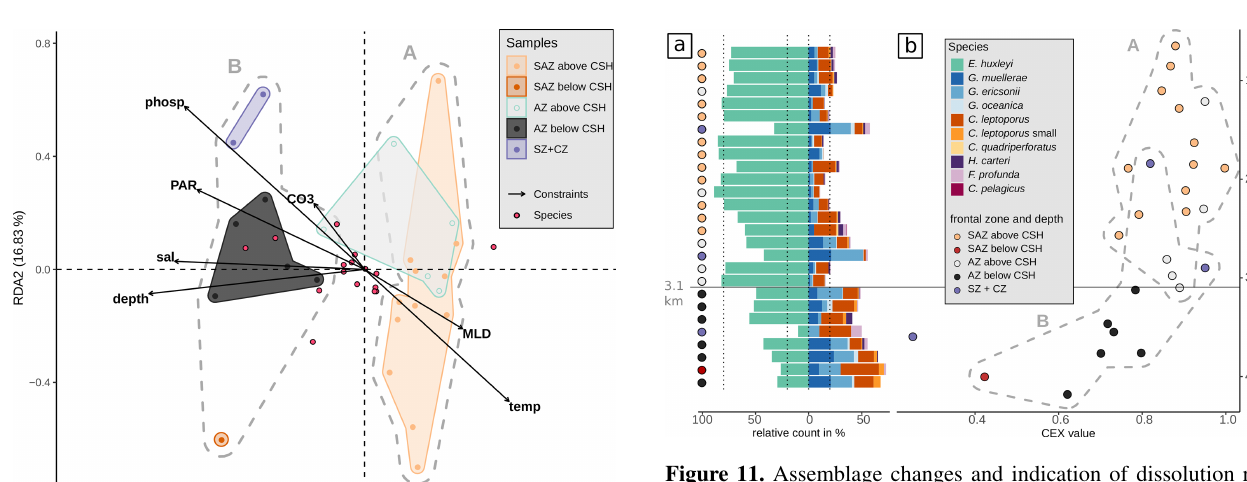
Figure 11. Assemblage changes and indication of dissolution re- lated to water depth. (a) Relative proportions of the delicate E. hux- leyi versus the more dissolution-resistant Gephyrocapsa and Cal- cidiscus taxa as well as H. carteri , F. profunda and C. pelagicus . Figure 10. Redundancy analysis based on Hellinger distances (tb- Below 3.1km and in the SZ + CZ, species of the genera Gephyro- RDA) with an explained variation in species composition by the in- capsa and Calcidiscus dominate the surface sediment assemblages. put environmental variables (adjusted R 2 ) of 38.3%. Biplot of the (b) Calcidiscus leptoporus – Emiliania huxleyi Dissolution Index first two RDA axes explaining 84.3% of the (constrained) variance (CEX, Dittert et al., 1999; see Eq. 2) against water depth. Dashed between the environmental parameters (black arrows), the species outlines indicate the clusters A and B as suggested by cluster analy- (blue dots) and the samples (coloured dots). Grey dashed hulls out- sis, distinguishing clearly the shallower samples above 3.1km from line the clusters (A and B) from the hierarchical cluster analysis; deeper samples below 3.1km (and from SZ + CZ), with the highest coloured hulls outline the samples from different frontal zones and CEX values in cluster B. The sample outside cluster B (PS97/077- above or below a depth of 3.1km. Considered explaining variables 1) was not included in the hierarchical cluster analysis. Note that the are sample depth (depth), mixed-layer depth (MLD), temperature proportion of the dissolution-resistant taxa increases below 3.1km (temp), salinity (sal), phosphate (phosp) and photosynthetically ac- and that CEX values decrease in parallel. CEX values < 0.75 are tive radiation (mean from December to February, PAR) at 10m wa- exclusively found for samples below 3.1km water ter depth and CO 2 − (CO3) at sample depth. 3